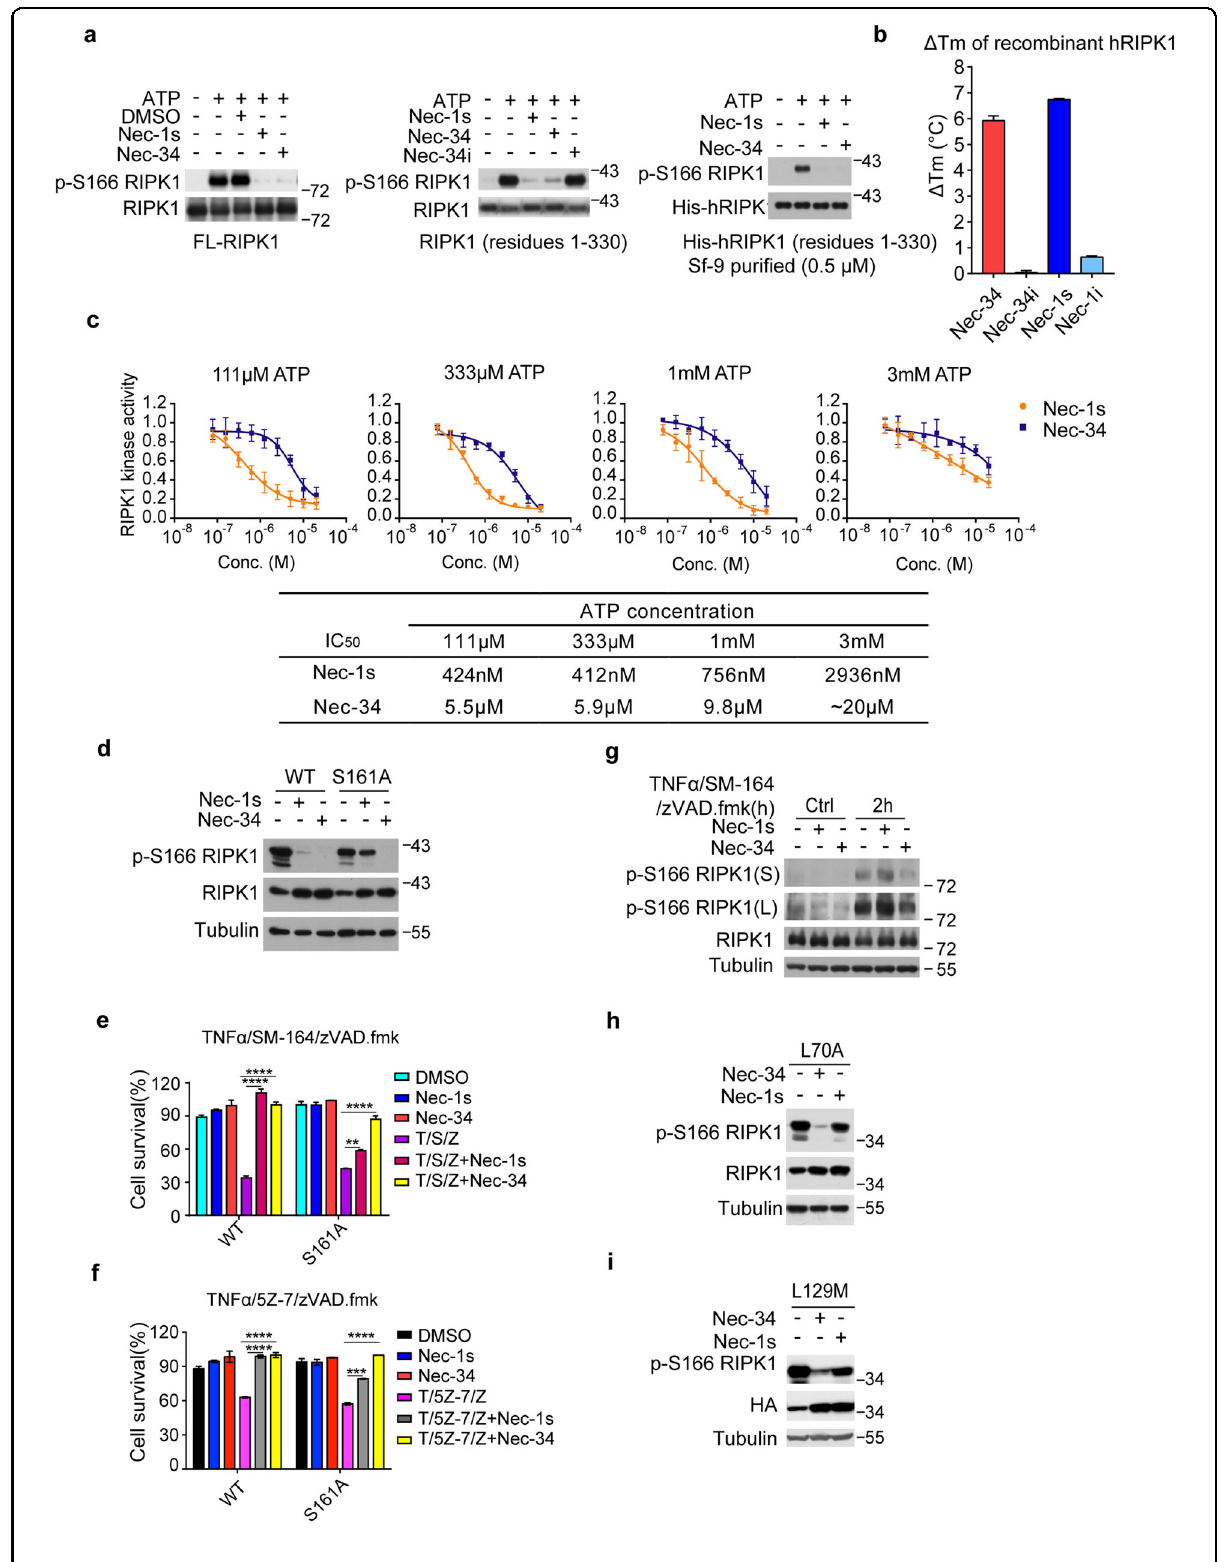
Fig. 3 (See legend on next